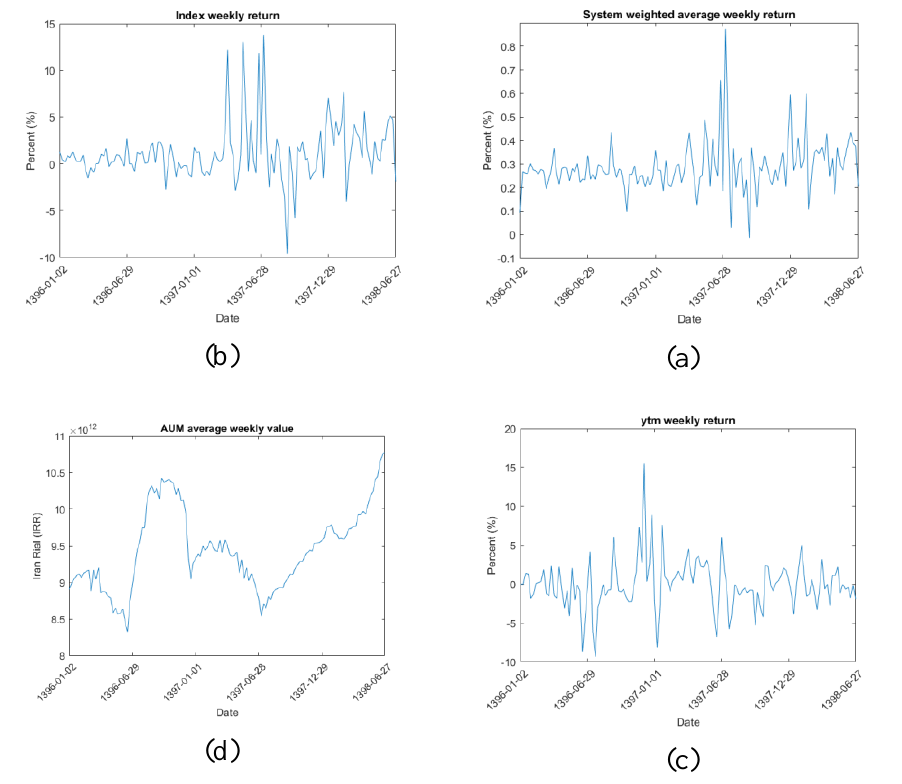
Figure 1. The Graphs of a) Mean Variations in Weekly Return of System, b) Weekly Return TEDPIX, c) Weekly Variation Yield to Maturity of Treasury Bills, and d) Net Asset